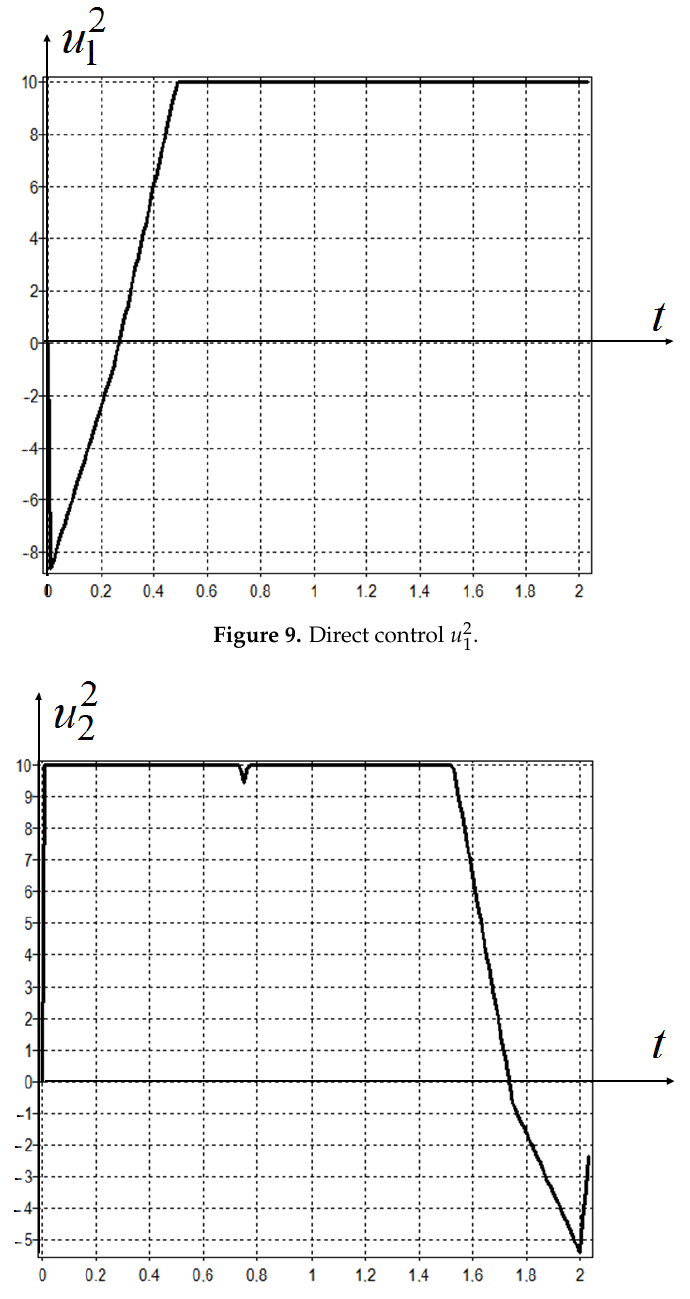
Figure 10. Direct control u 2